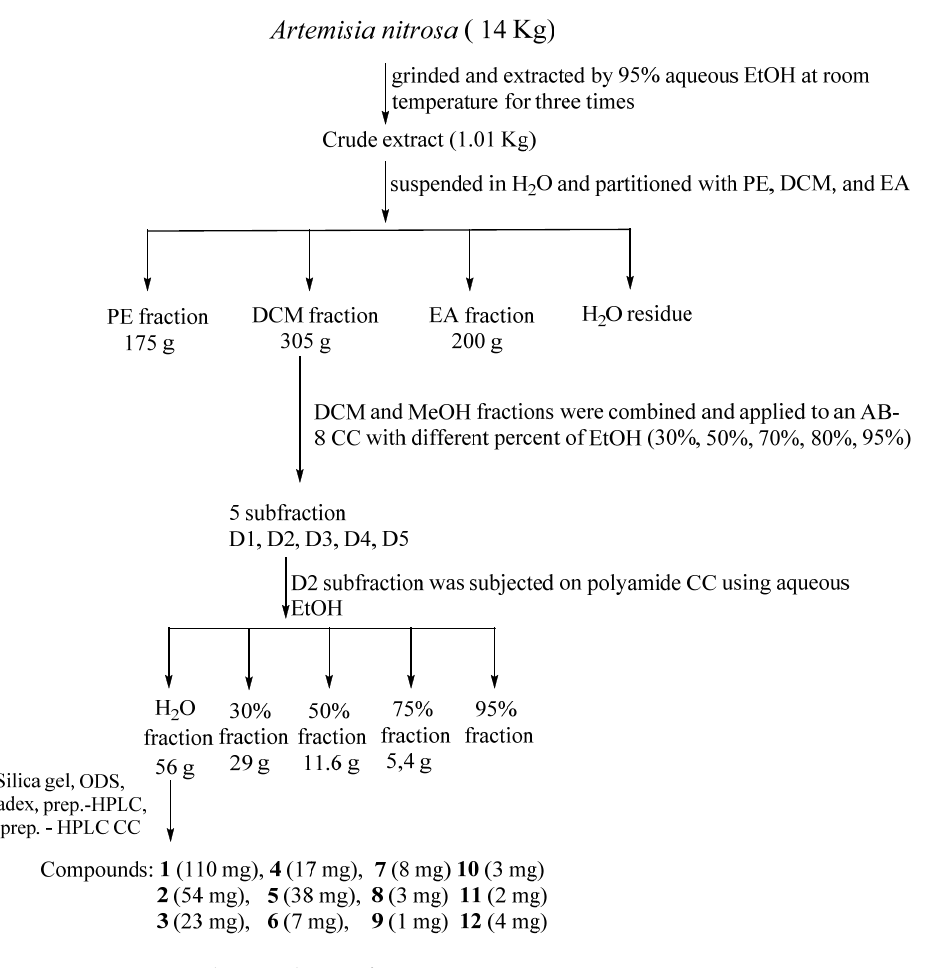
Figure 1. Isolation scheme of A. nitrosa.